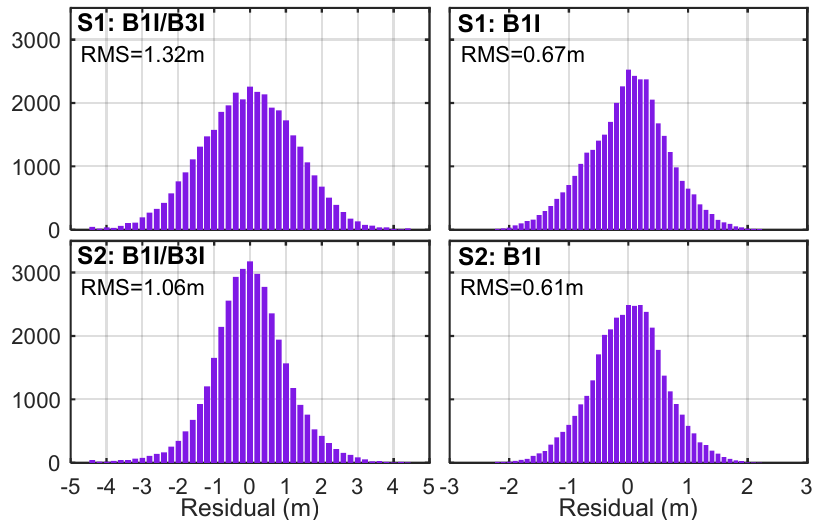
Figure 11. SPP residuals of B1I / B3I ( left ) and B1I ( right ) SPP at station MCHL (Mitchell, 26.36 ◦ S, 148.15 ◦